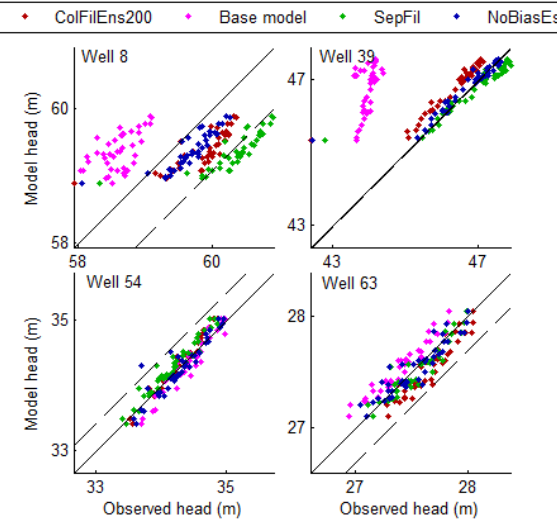
Figure 6. Model observations versus synthetic observations in se- lected observation locations. The dashed line indicates the 1:1 line when corrected for the applied bias. Note that the plotted model observations are the forecasted model observations, i.e. before the states are updated in the